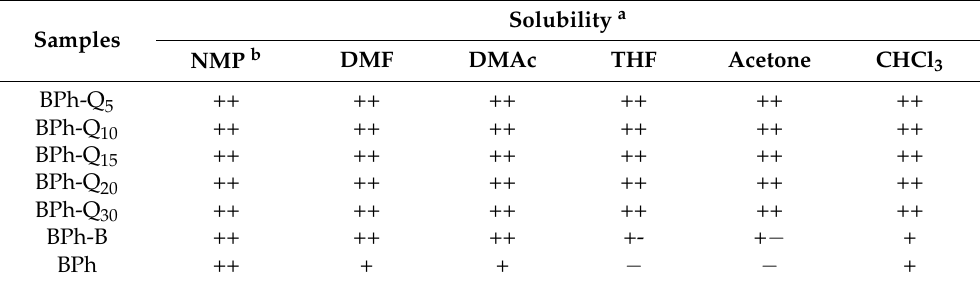
Table 1. Solubility of BPh prepolymers.